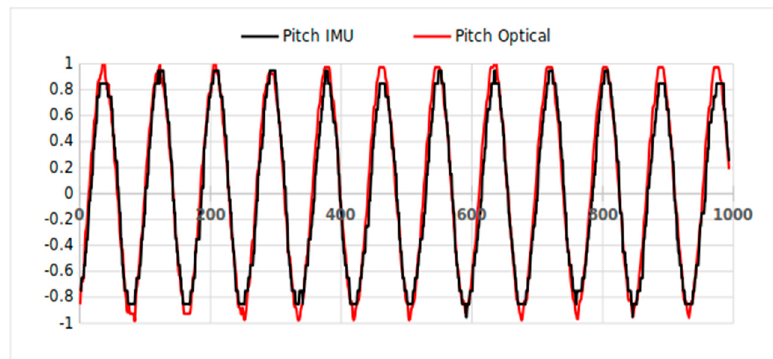
Figure 2. Results of using the IMU to test a Computer Vision tracking algorithm using a pendulum movement (in